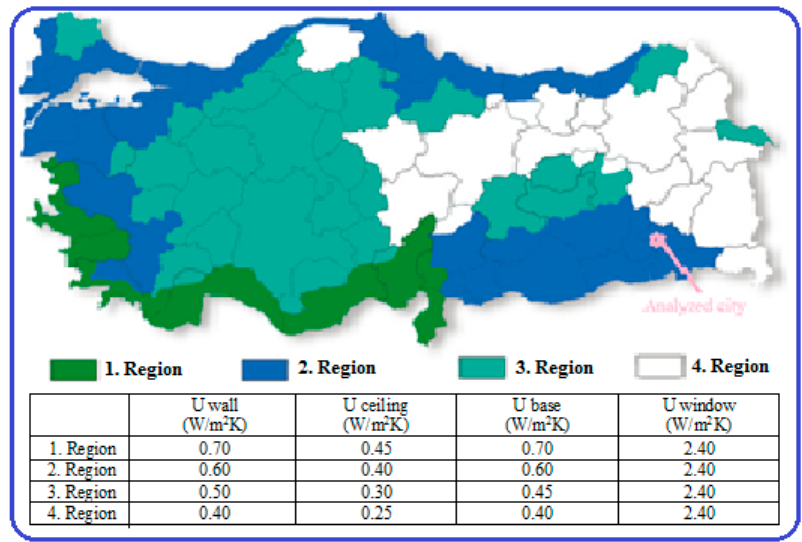
Figure 1. The climatic regions and location of the analyzed building according to TS 825 of Turkey [3].